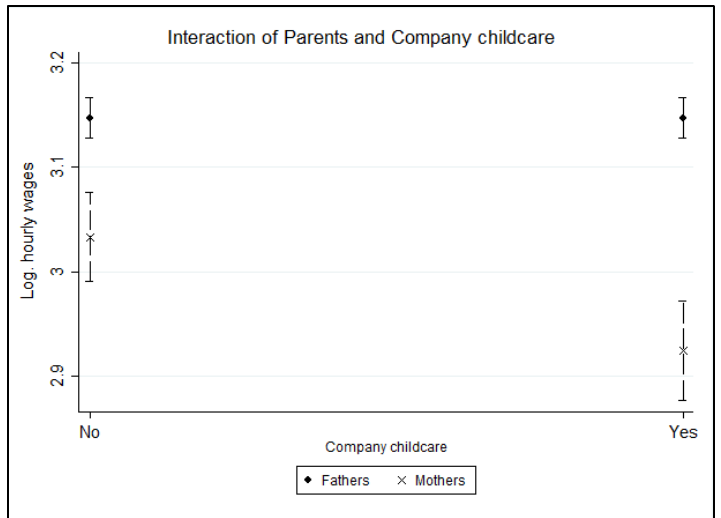
Figure 2. Log hourly wages of fathers and mothers by the offer of company childcare in establishments without EQM (predictive margins of parents with 95% CIs using Stata 14; based on Table 5). For establishments that simultaneously offered EQM and WLM, the patterns changed.